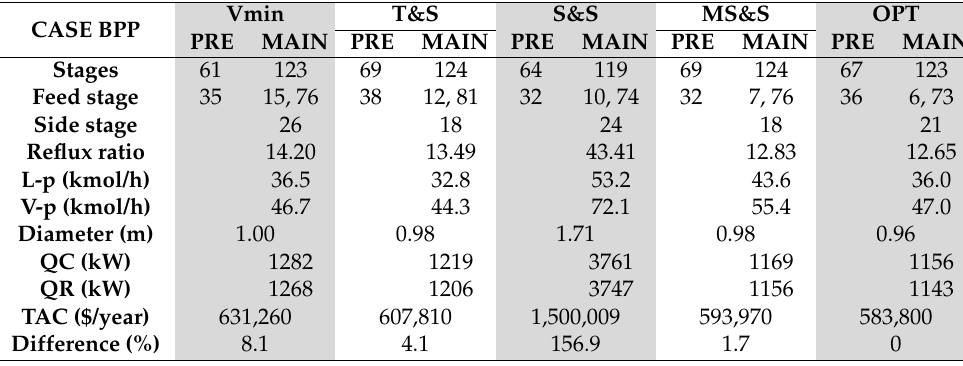
Table 4. Results for the n-Butane, i-Pentane, and n-Pentane (BPP) mixture. CASE